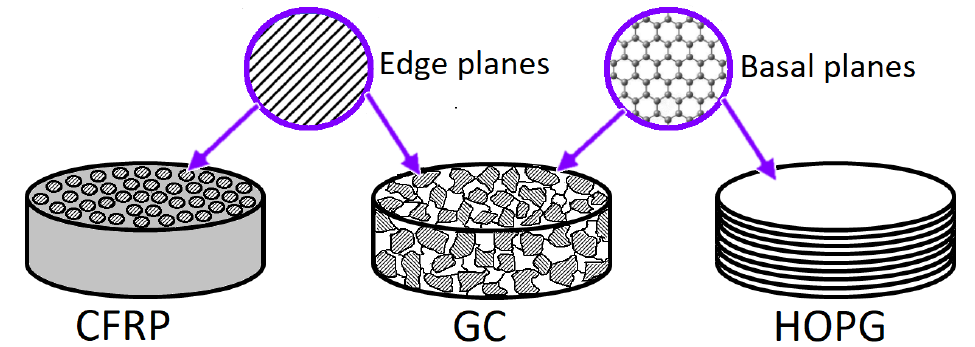
Figure 9. Schematic representation of the hypothesized differences in electrochemically active surfaces of the carbon surfaces studied.